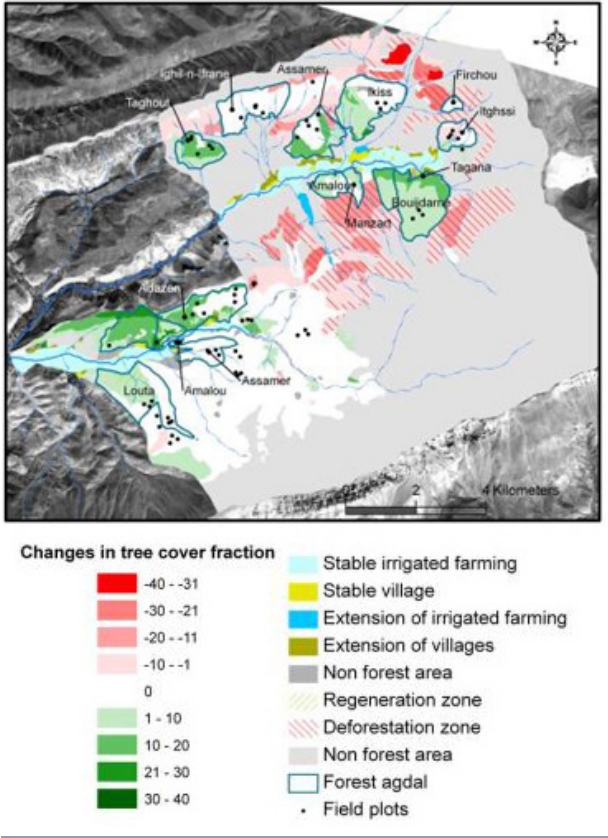
Fig. 4 . Dynamics of the tree cover in the upper valley of the Aït Bouguemmez between 1964 and 2002 (adapted from Hammi et al.